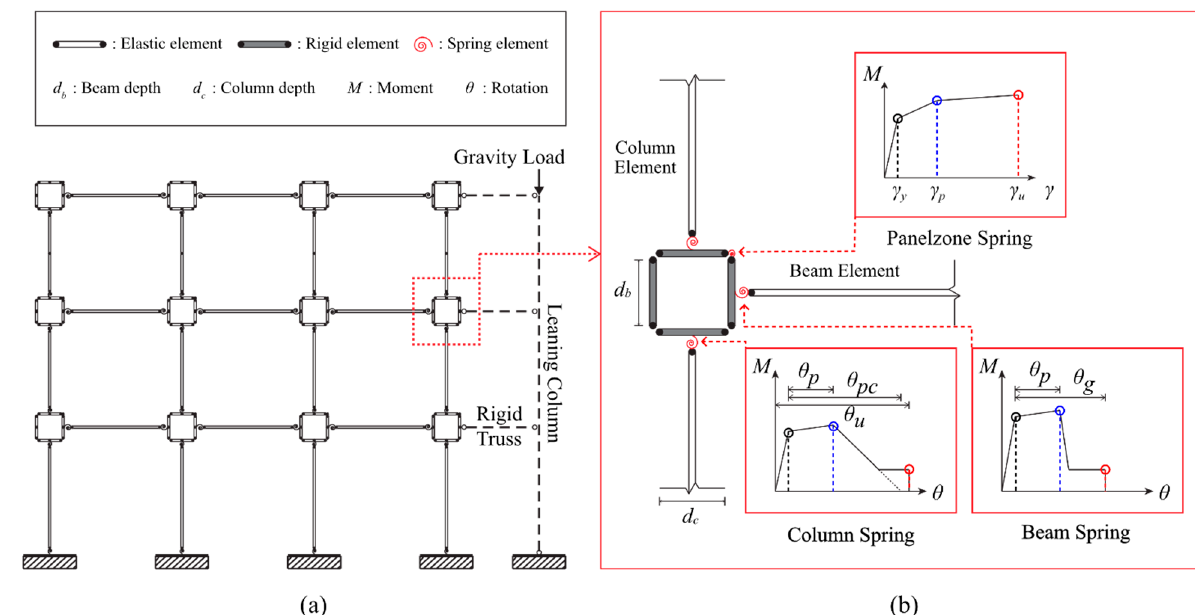
Figure 3. Numerical model for model structure: ( a ) Model configuration of steel OMF; ( b ) detail of the beam-to-column connection model.